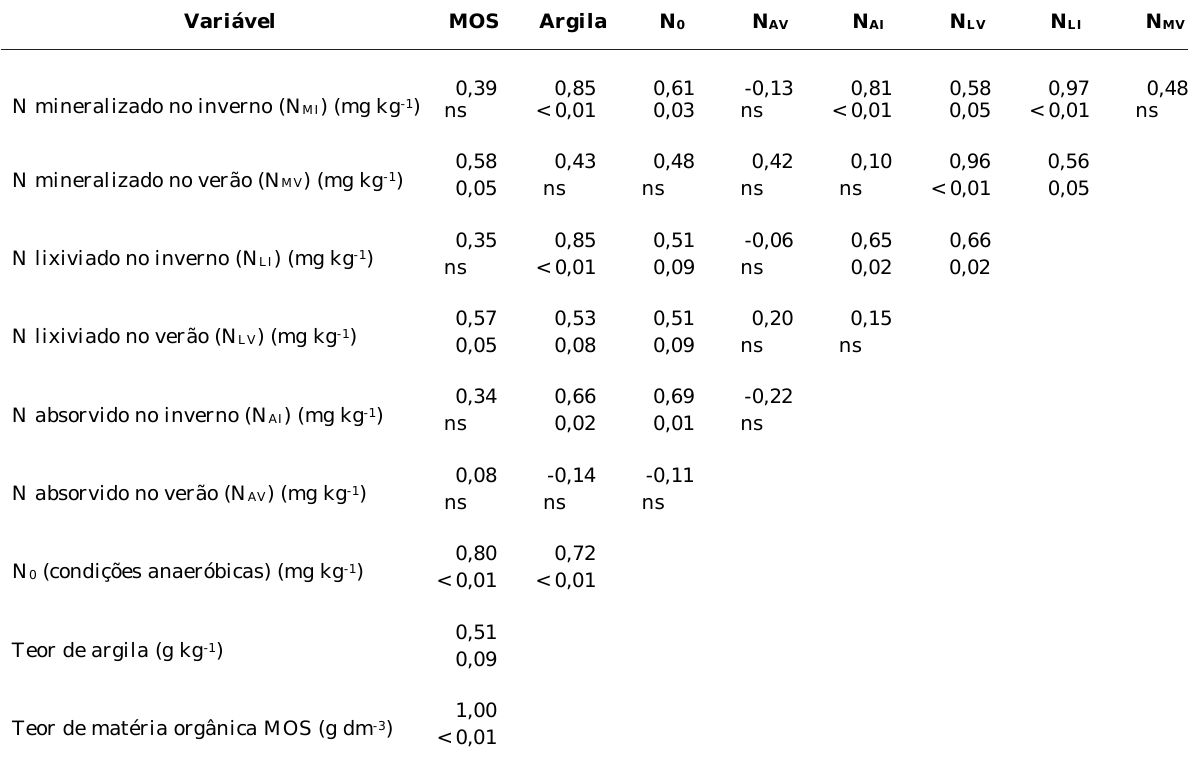
Variável MOS Argila